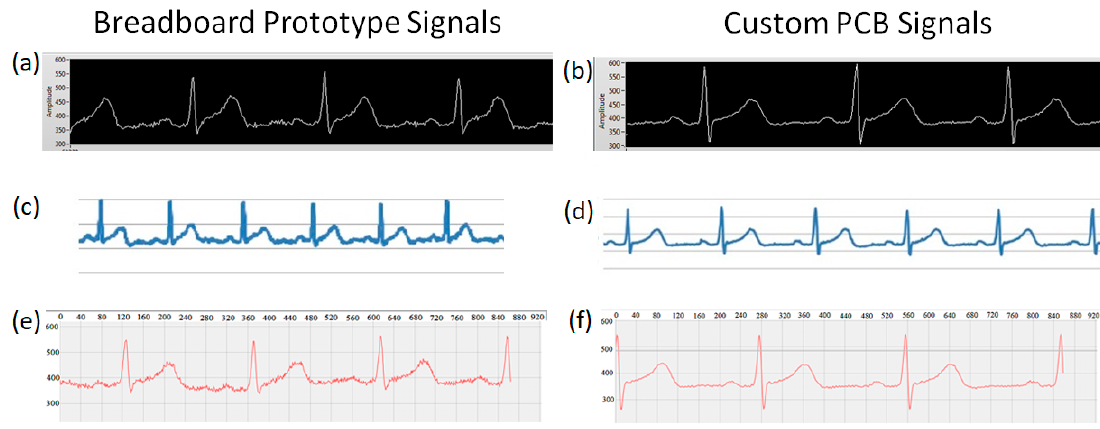
Figure 17. Snapshots of di ff erent operating modes with their respective visualization software: ( a ) ECG signal transmitted by serial cable (breadboard prototype); ( b ) ECG signal transmitted by serial cable